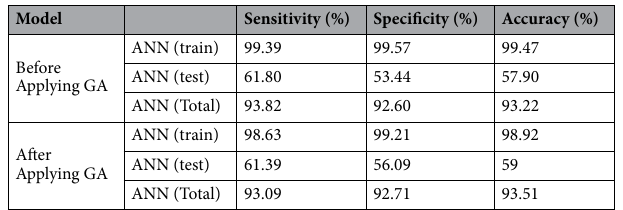
Table 3. The results obtained from implementing the neural network before and after feature selection using GA.